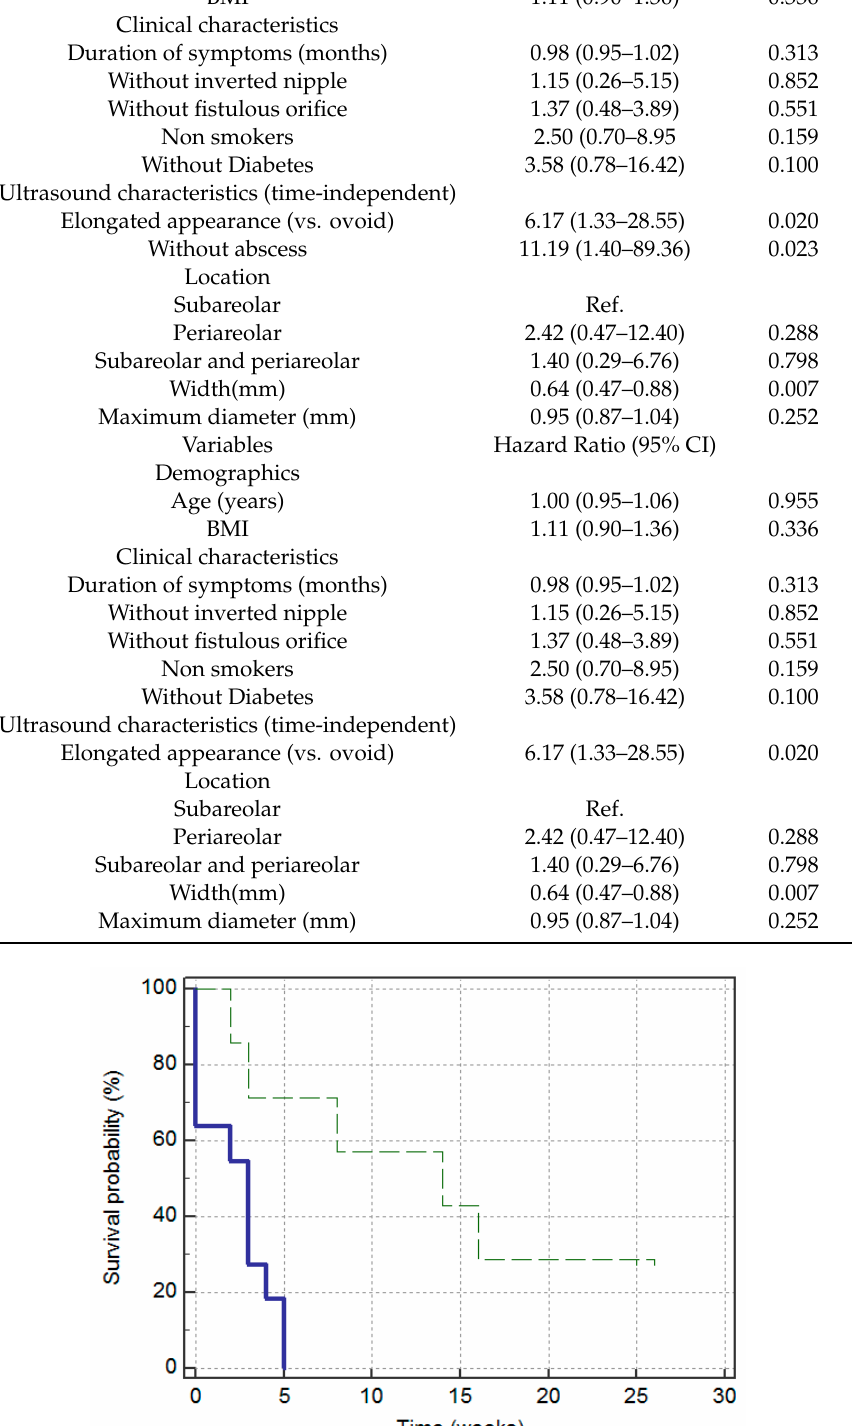
Figure 4. Kaplan–Meier survival curves demonstrating remissions over a period of 26 weeks, according to fistula appearance: elongated (solid line) and ovoid (dashed line).